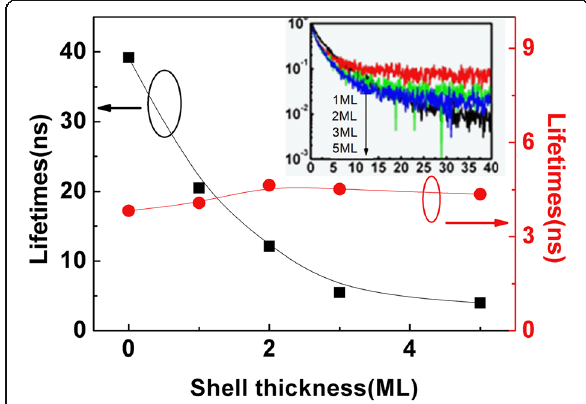
Fig. 4 Fluorescence lifetime of ZnSe QDs ( I B ) and that of Eu ( I 613 ) with different Zne shell thickness. The inset is time-resolved PL spectra of band-edge luminescence peak of ZnSe QDs ( I B ) with different ZnS shell